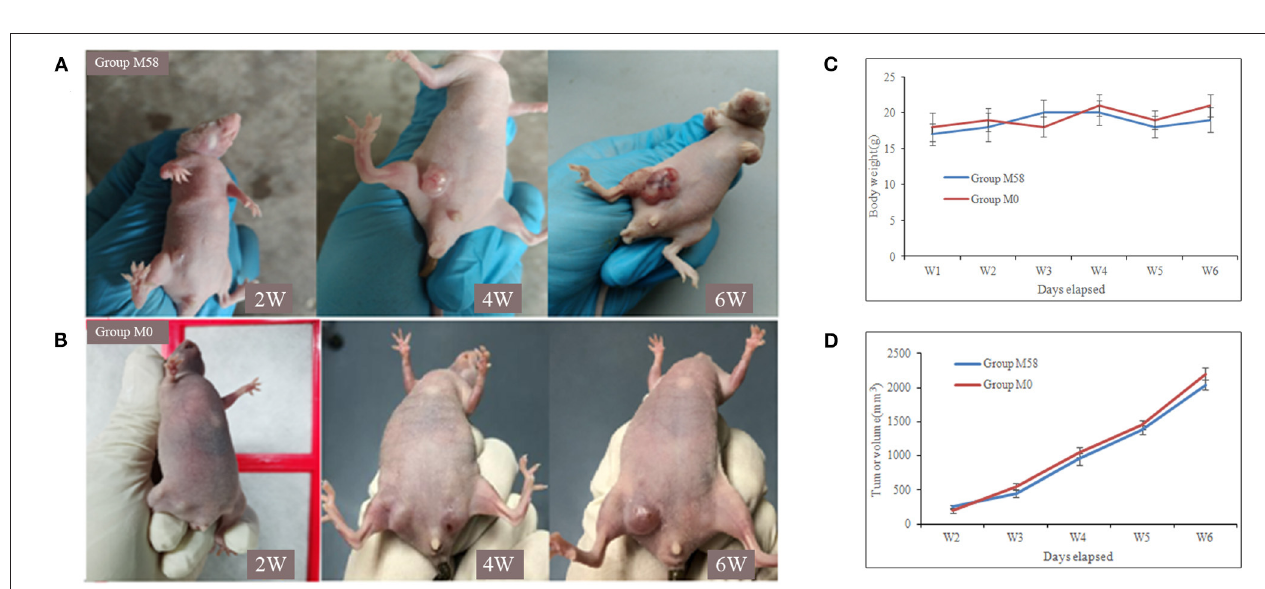
FIGURE 5 | Tumor formation of nude mice after breast cancer stem cell (BCSC) inoculation. (A,B) The MDA-MB-231 BCSCs were injected subcutaneously in the armpit of the right lower limb, and the tumor formed and increased gradually. The nude mice of group M58 were used for the specificity identification of polypeptide M58 and group M0 for control peptide M0. (C) The body weights of the mice in two groups and the difference between them were not statistically significant. (D) Tumor volume was measured using a caliper and calculated as (width 2 × length)/2; the tumor volume of the two groups was not statistically significant.